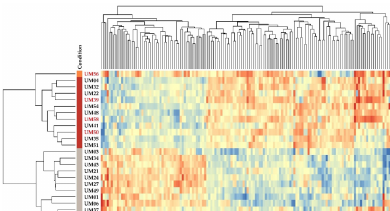
Figure 6. A heatmap of EMT-associated genes mRNA expression in UM tumors with at least 2-fold change. Chromosome 3 status is shown on the left side, M3 tumors are highlighted in brown, D3 tumors are highlighted in gray. UM56 highlighted in orange, a metastatic patient with 1p loss and 8q gain, whose disease status was discussed earlier, showed greater similarity with the M3 group. As the mRNA expression of three other metastatic patients (red numbers) showed a similar pattern as those with primary UM, they were included in the heatmap. The red color represents up-regulated gene expression, the blue color represents down-regulated gene expression, while the yellow represents no